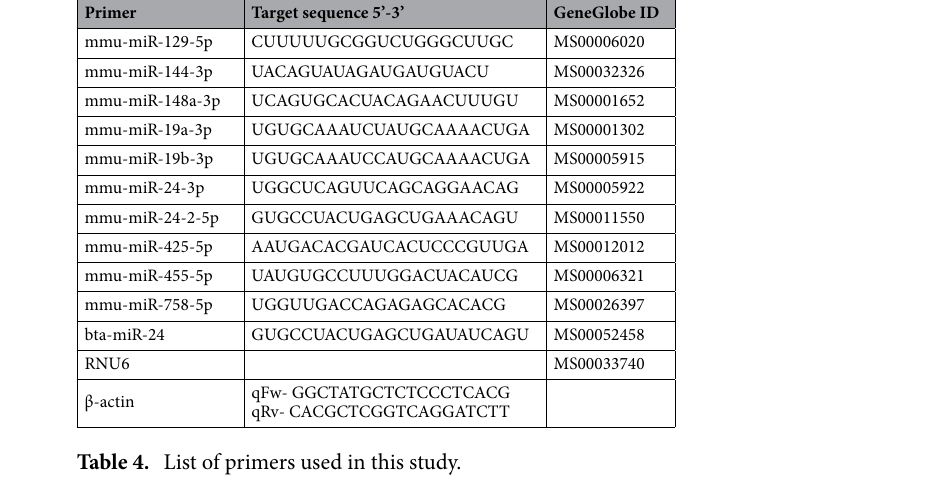
Buffy coats were then layered over Ficoll-Paque Plus and white blood cells collected and resuspended in DMEM complete culture media. PBMCs were maintained in DMEM with 20% FBS and stimulated with rHuM-CSF (1 ng/mL) (Sigma-Aldrich, USA) to differentiate adhered PBMCs into monocyte-derived macrophages (MDM), identified by visual phenotyping of cytoplasmic granules, elongated shape, and characteristic cellular protru- sions. Adhered cell0073 were cultured in duplicate in DMEM with 20% FBS without antibiotics and infected with MAP (C strain C0912) at MOI 10:1 and incubated for the required time. Cell harvesting and RNA extraction. For the harvest of RAW 264.7 cells, culture supernatant was aspi- rated and stored at − 20 °C for future use, and 500 µL of RNAzol RT (Sigma-Aldrich, USA) was added to the well and mixed before transferring the entire volume to a 1.5 mL screw cap tube on ice. For BoMac and primary macrophages, media was removed, and flasks were washed with 1 mL of RNAzol RT (Sigma-Aldrich, Australia), and the lysate transferred to a 2 mL tube and frozen at − 80 °C until processed. RNA was extracted from RNAzol